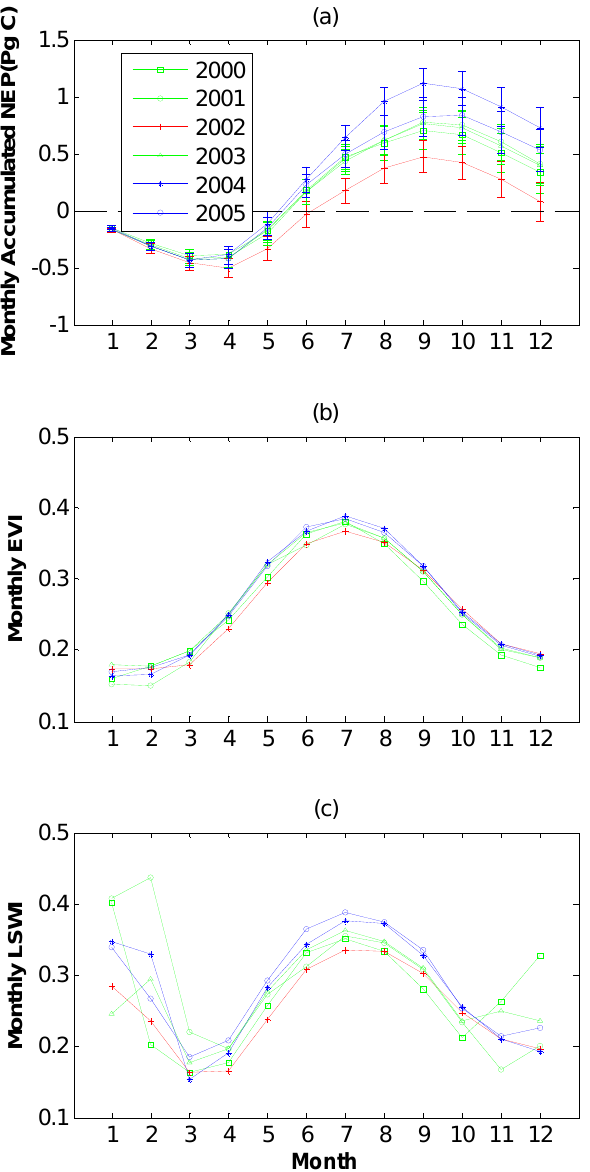
Fig. 6. Comparison between NEP, EVI, and LSWI across the con- terminous United States over the period of 2000–2005: (a) Cumu- lative monthly NEP estimated by SAT-TEM. (b) Monthly averaged regional EVI. (c) Monthly averaged regional